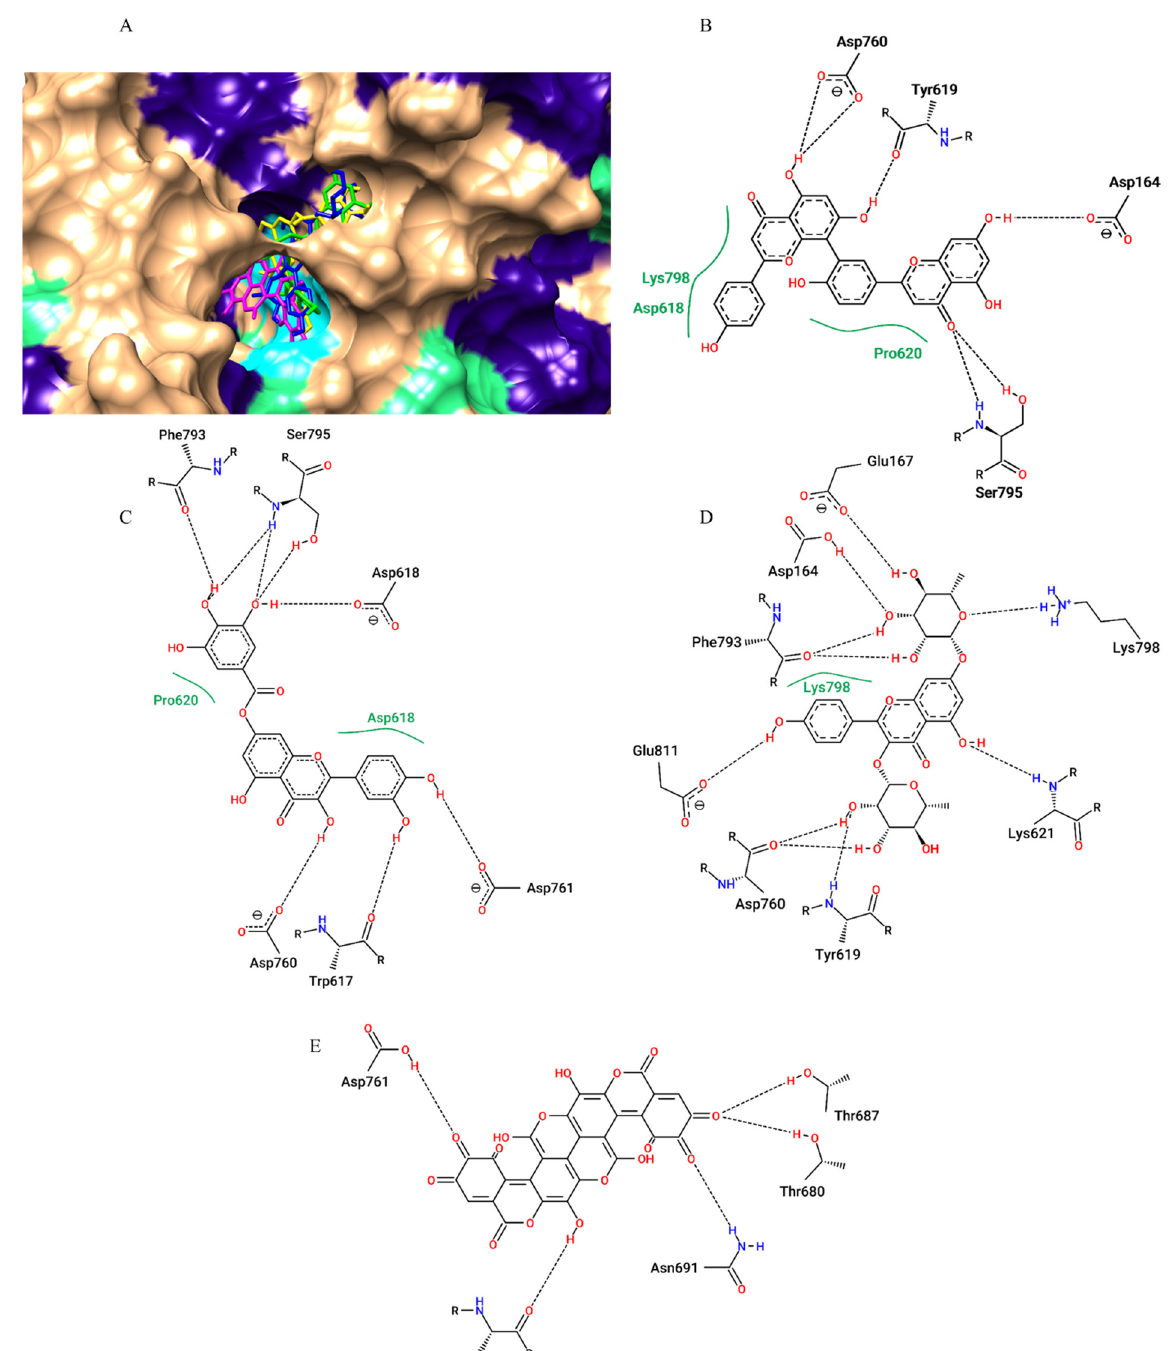
Figure 3. Surface representation of plant metabolites docking positions on the SARS-CoV-2 RdRp active site, with amentoflavone (green), kaempferitrin (blue), 7-O-galloylquercetin (yellow), and gallagic acid (magenta) ( A ). The two-dimensional diagram from contacts of SARS-CoV-2 RDRP active site residues with amentoflavone ( B ), 7-O-galloylquercetin ( C ), kaempferitrin ( D ) and gallagic acid ( E ) Dashed black lines indicate hydrogen bonds; full green lines indicate van der Waals interactions.